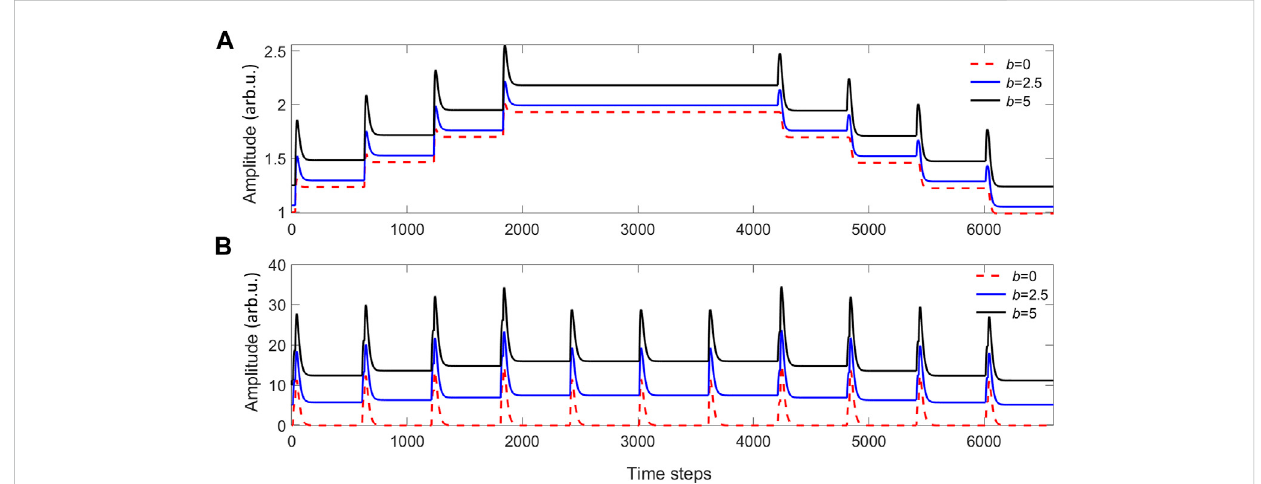
FIGURE 6 (A) Theplasticweights w 1 ,and (B) theICOlearningoutputs v ,fordifferentDCamplitudebiasvalues b oftheactivationinputspresentedinFigure 5B. The learning rate is η =0.01 and w 0 =1.